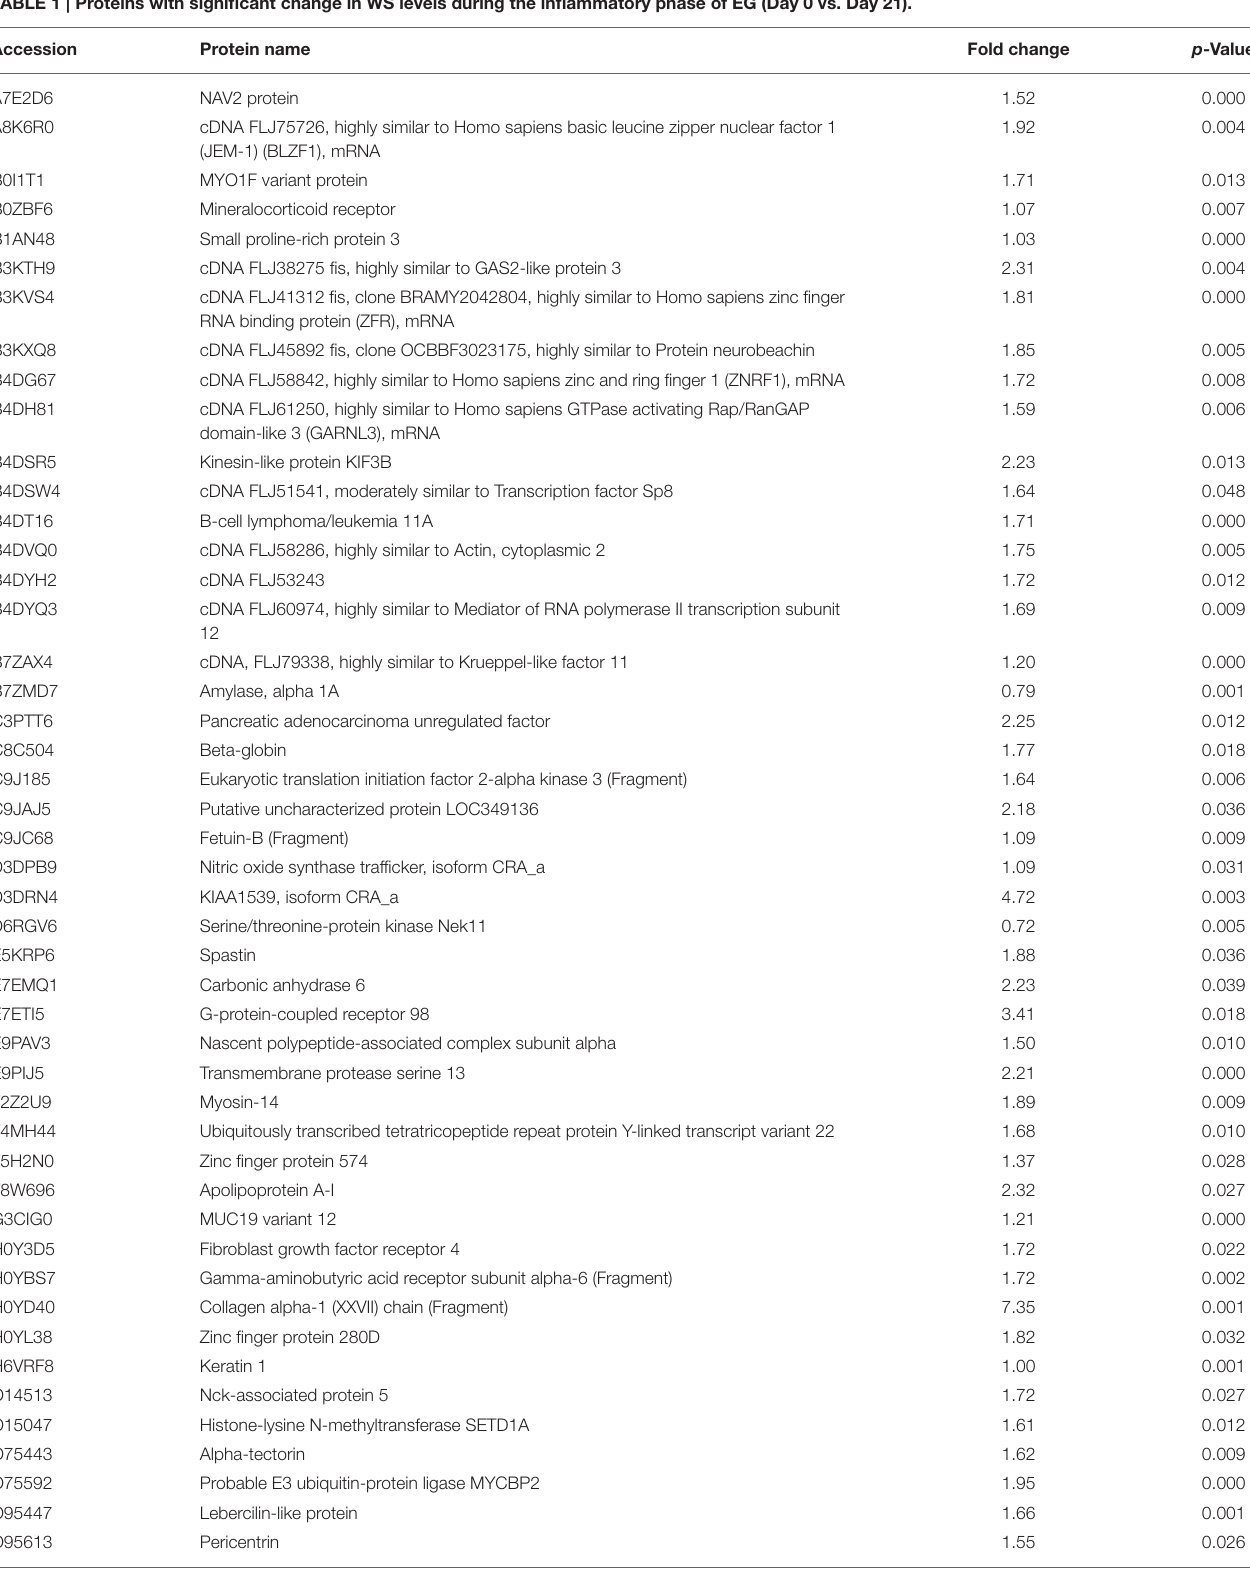
TABLE 1 | Proteins with significant change in WS levels during the inflammatory phase of EG (Day 0 vs. Day 21).